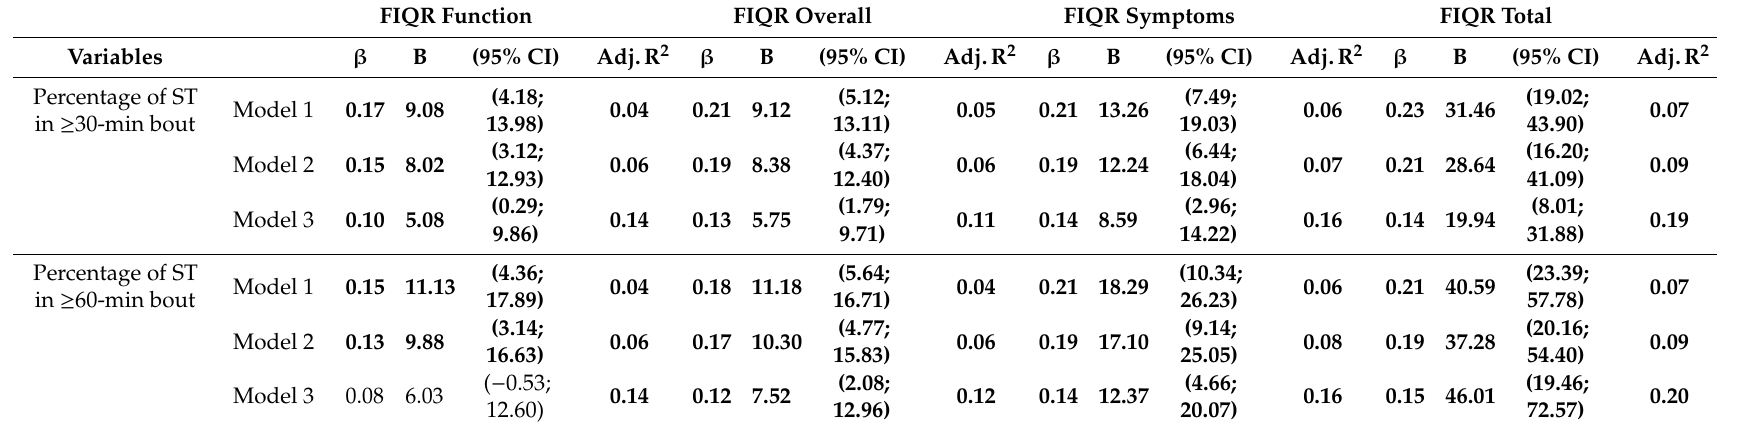
Table 3. Association of percentage of bouted sedentary time with disease severity, n =